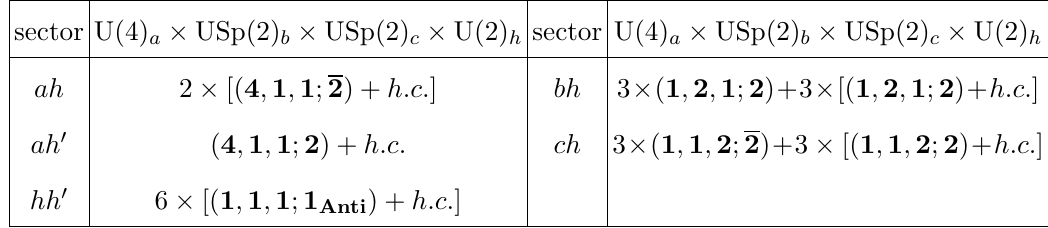
Table 24 . Chiral and vector-like massless ‘hidden’ matter spectrum of the prototype II global Pati-Salam model with D6-brane con(cid:12)guration in table 23. The observable spectrum is (up to the rank of stack a ) identical to the f a; b; c g sector of the L-R symmetric models, cf. table 19. Also in this prototype, both U(1) a (cid:2) U(1) d gauge factors acquire a St(cid:127)uckelberg mass, turning them into perturbative global symmetries in the low-energy e(cid:11)ective (cid:12)eld